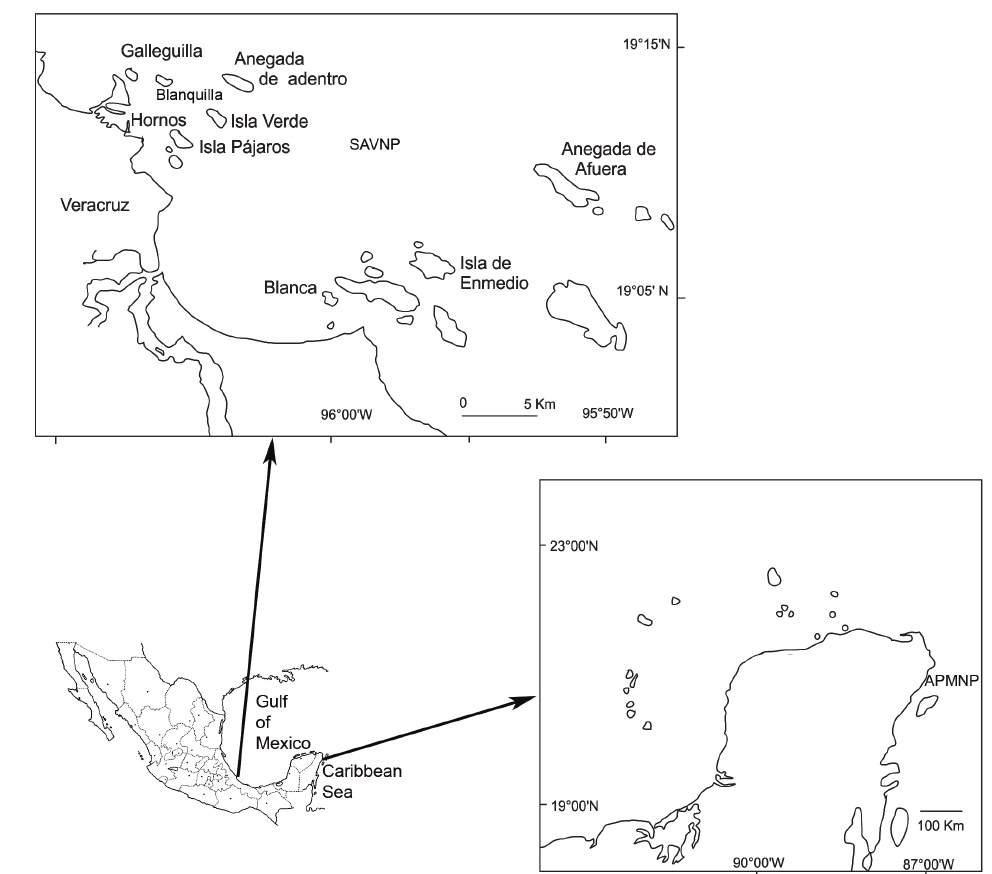
Figure 1. Location of sampling sites at the national parks Sistema Arrecifal Veracruzano (SAVNP) and Arrecife Puerto Morelos